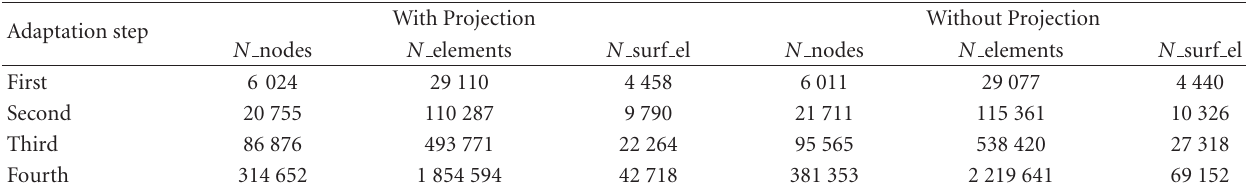
Table 1: Grid sizes for adapted pipe blade calculations: with and without projection algorithm.